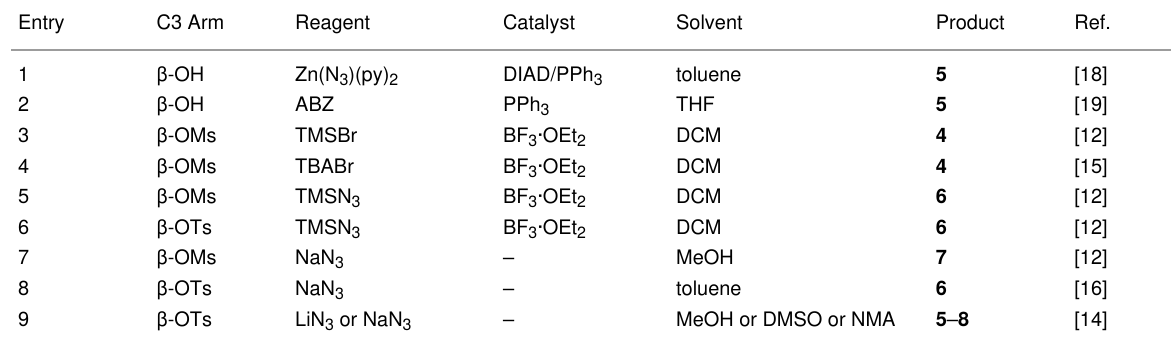
Table 1: Manipulations for bromination and azidation of